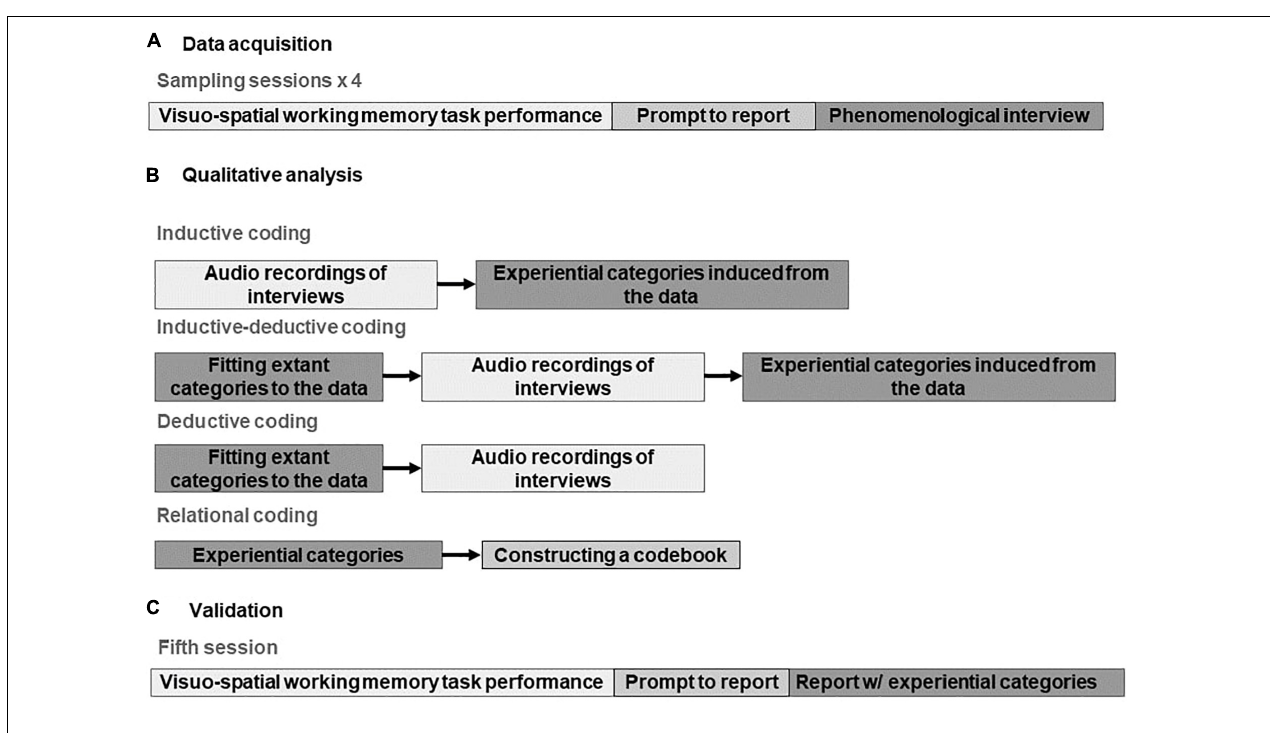
FIGURE 1 | (A–C) Overview of the research design.